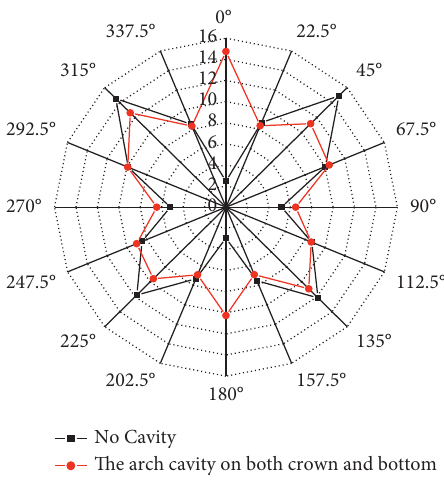
Figure 27: Safety coefficient of the segment cross section of arch waist and cavity behind the arch bottom.